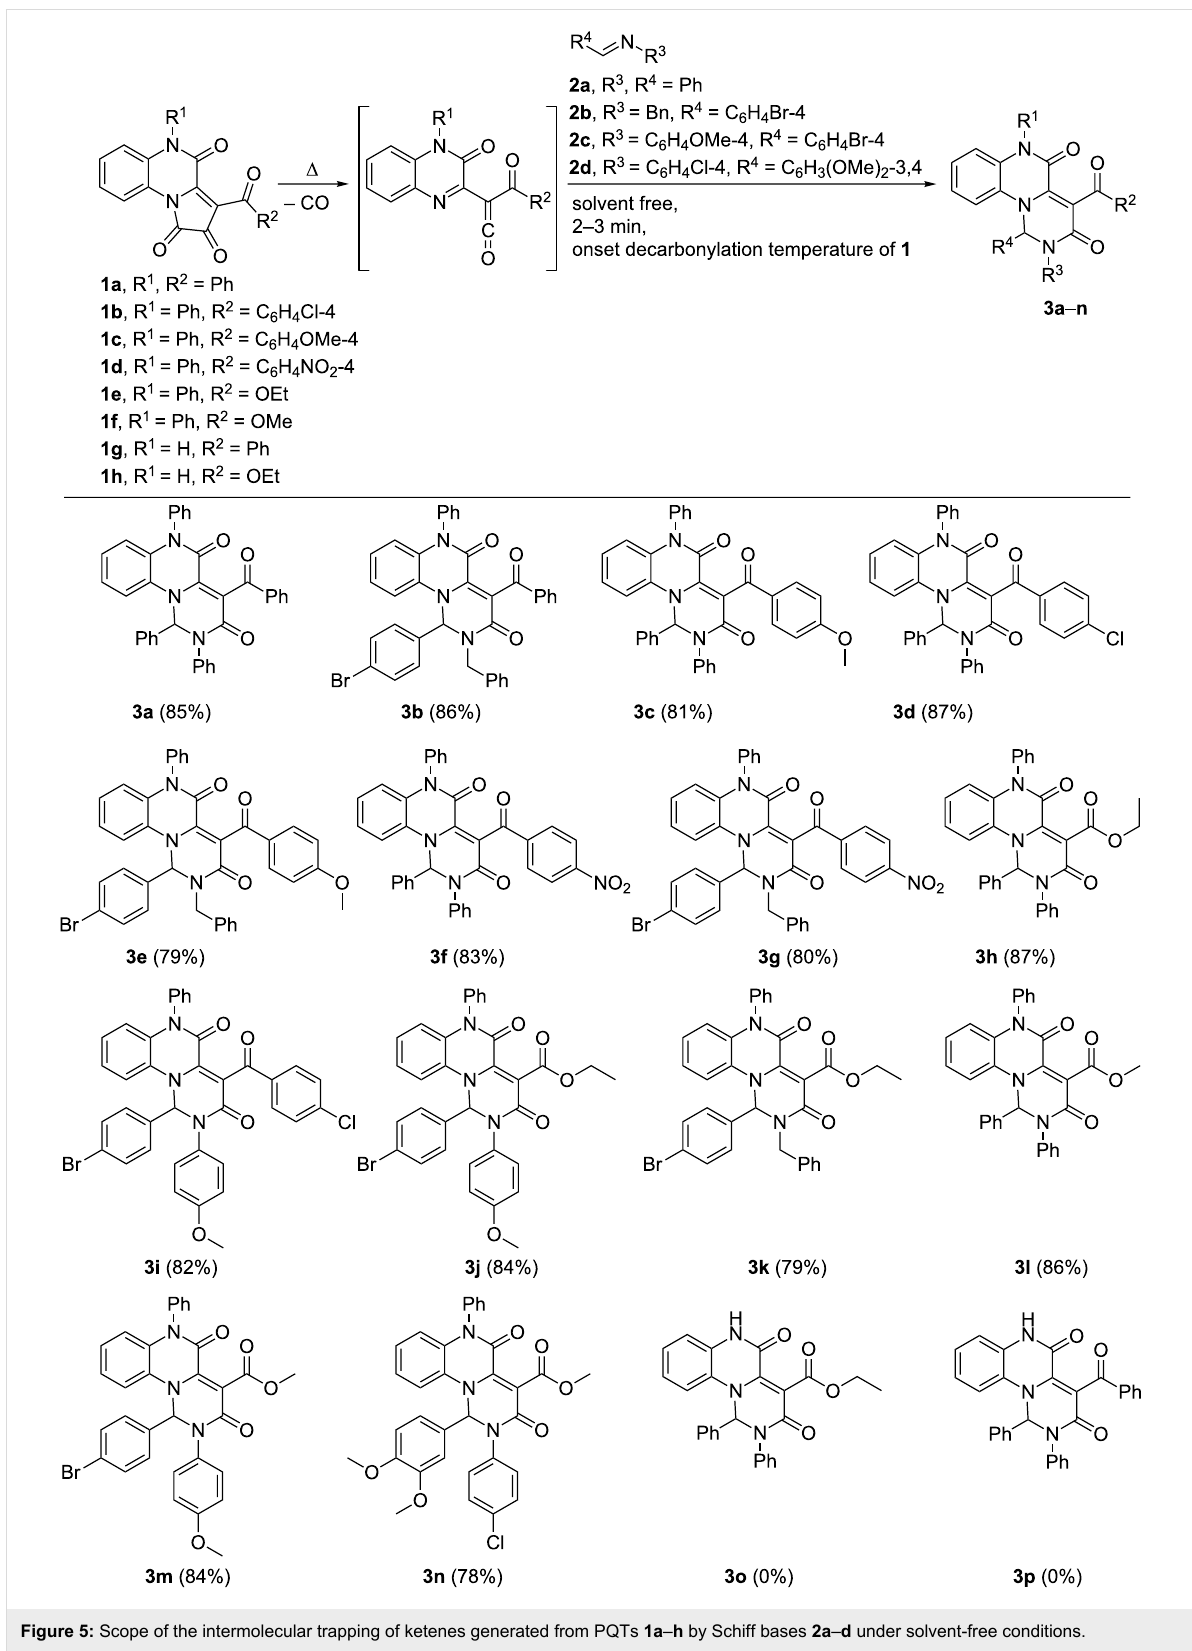
Figure 5: Scope of the intermolecular trapping of ketenes generated from PQTs 1a – h by Schiff bases 2a – d under solvent-free